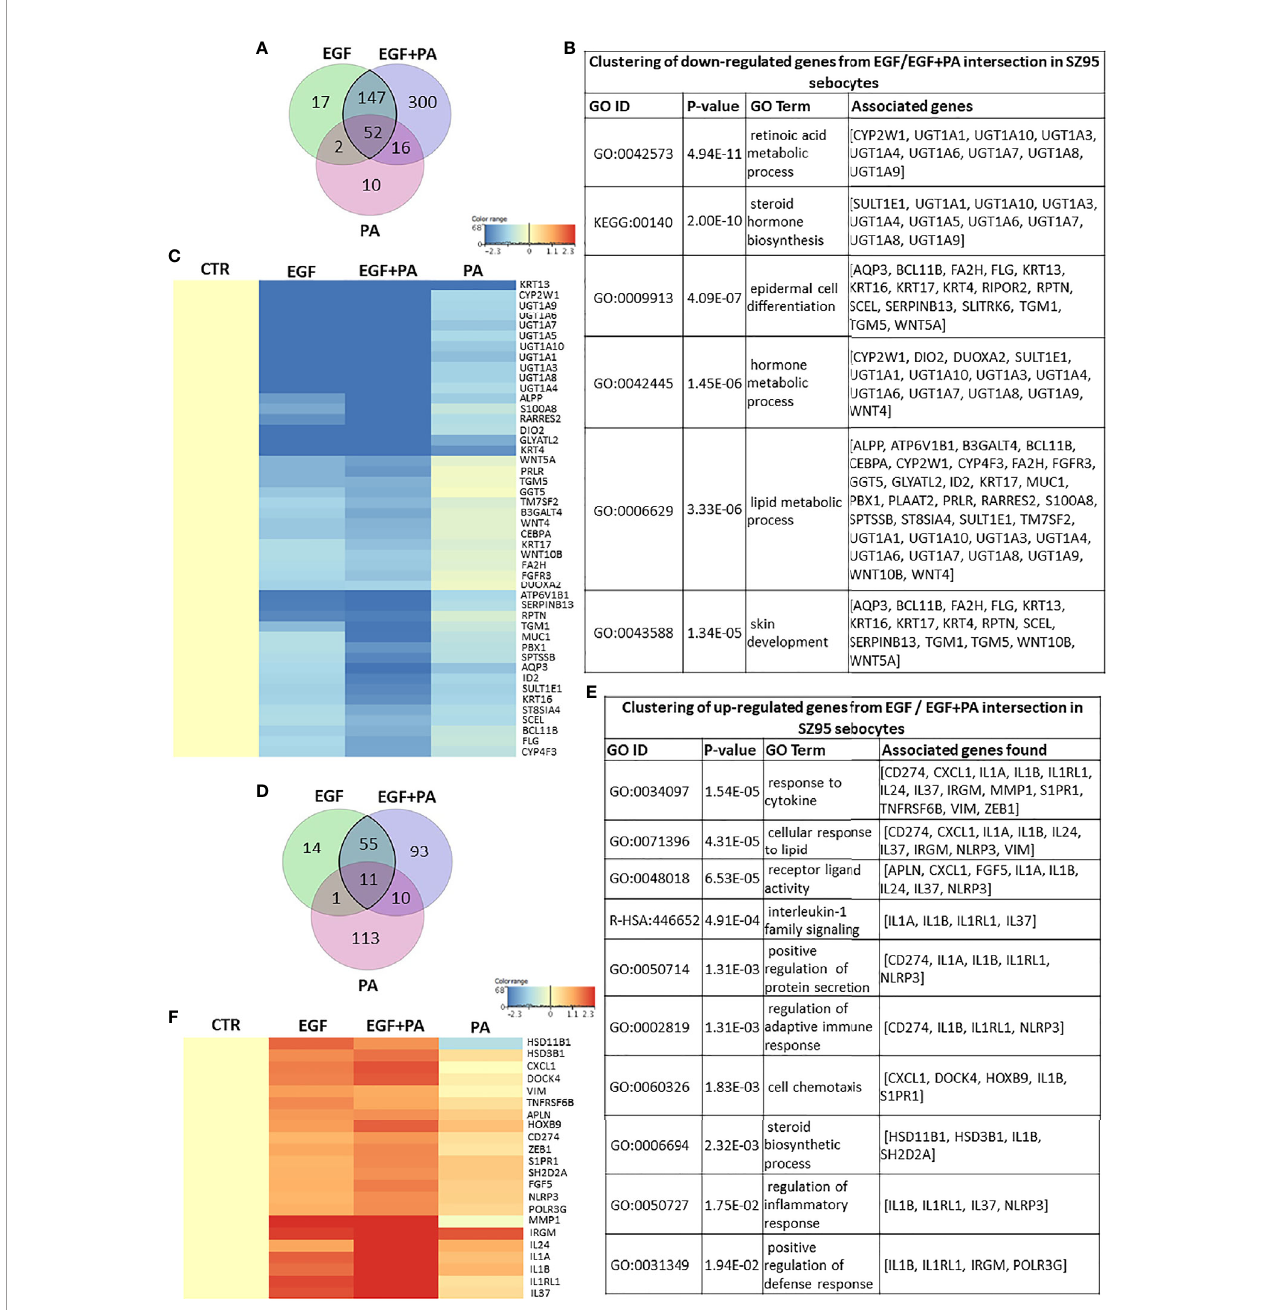
FIGURE 6 | Combined actions of PA and EGF on the gene expression pro fi le of SZ95 sebocytes. (A) Venn diagram showing the 199 transcripts which were signi fi cantly down-regulated when EGF or EGF+PA was used in combination to treat SZ95 sebocytes, as observed by our RNA-seq analysis. (B) Functional clustering of the 199 transcripts showing signi fi cant down-regulation in the EGF and the EGF+PA co-treated SZ95 sebocytes revealed that the most signi fi cant changes were related to genes involved in hormone and lipid metabolic processes of sebocytes. (C) Heat map display of the transcripts which were clustered out of the 199 transcripts with signi fi cant down-regulation both in the EGF and the EGF+PA co-treated SZ95 sebocytes. Differentially expressed genes were normalized to control and results are expressed as average mean of three samples from subcultures of SZ95 sebocytes. Color intensities re fl ect the ratios of signal intensities. (D) Venn diagram showing the 66 transcripts which were signi fi cantly up-regulated when EGF or EGF+PA was used in combination to treat SZ95 sebocytes, as observed by our RNA-seq analysis. (E) Functional clustering of the 66 genes displayed in the Venn diagram de fi ned that EGF alone and in combination with PA regulated immune features of SZ95 sebocytes, notably IL1 signaling. (F) Heat map display of the genes which were clustered out of the 66 differentially expressed transcripts. Differentially expressed genes were normalized to control and results are expressed as average mean of three samples from subcultures of SZ95 sebocytes. Color intensities re fl ect the ratios of signal intensities. Note the interaction between EGF and PA to regulate the expression of the genes which were already signi fi cantly regulated either by EGF or by